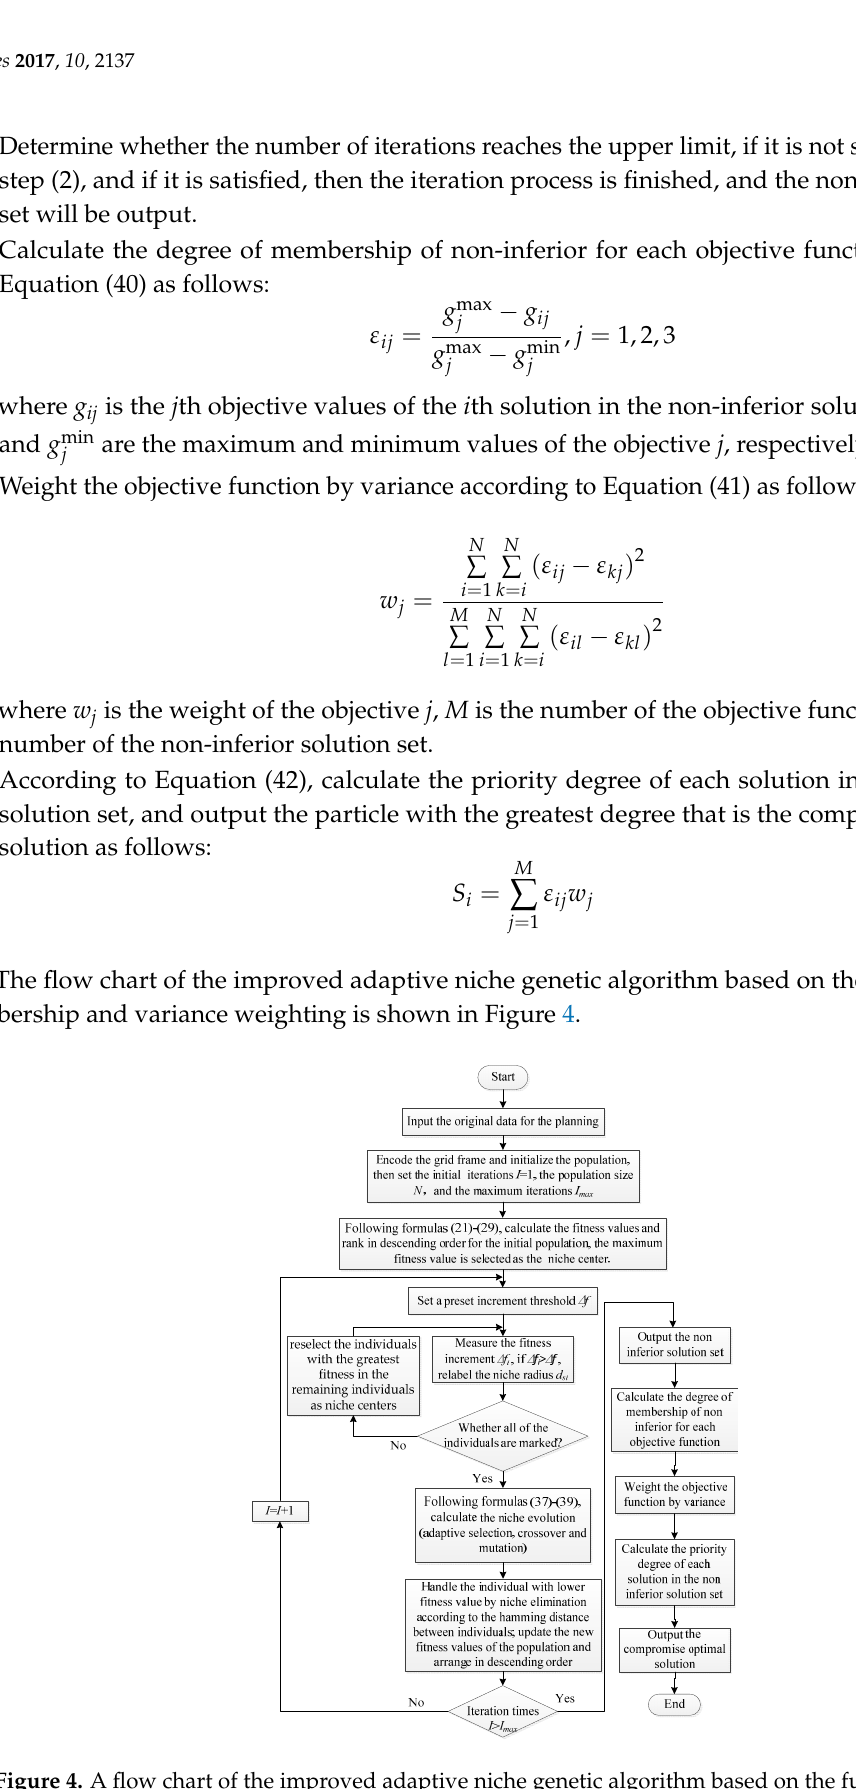
Figure 4. A flow chart of the improved adaptive niche genetic algorithm based on the fuzzy degree of membership and variance weighting.